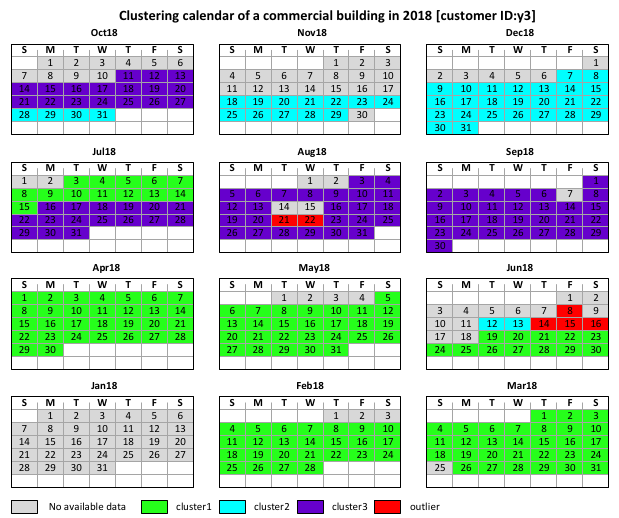
Figure 7. Clustering calendar of a commercial building in 2018 (customer ID: